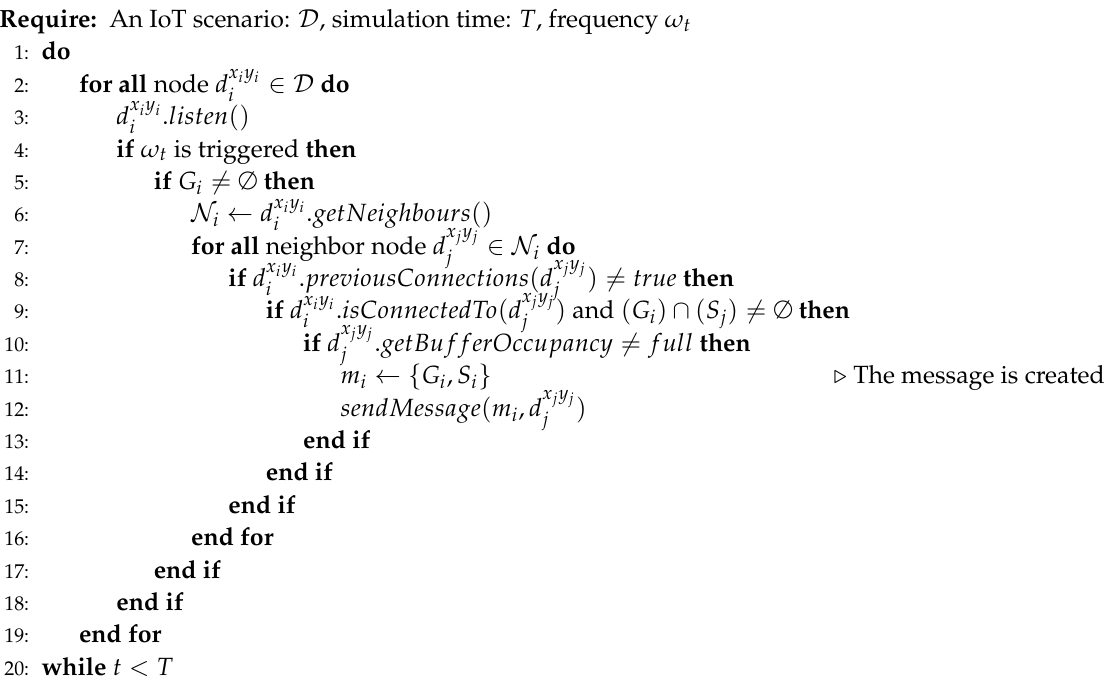
Algorithm 3 SACAR-IR